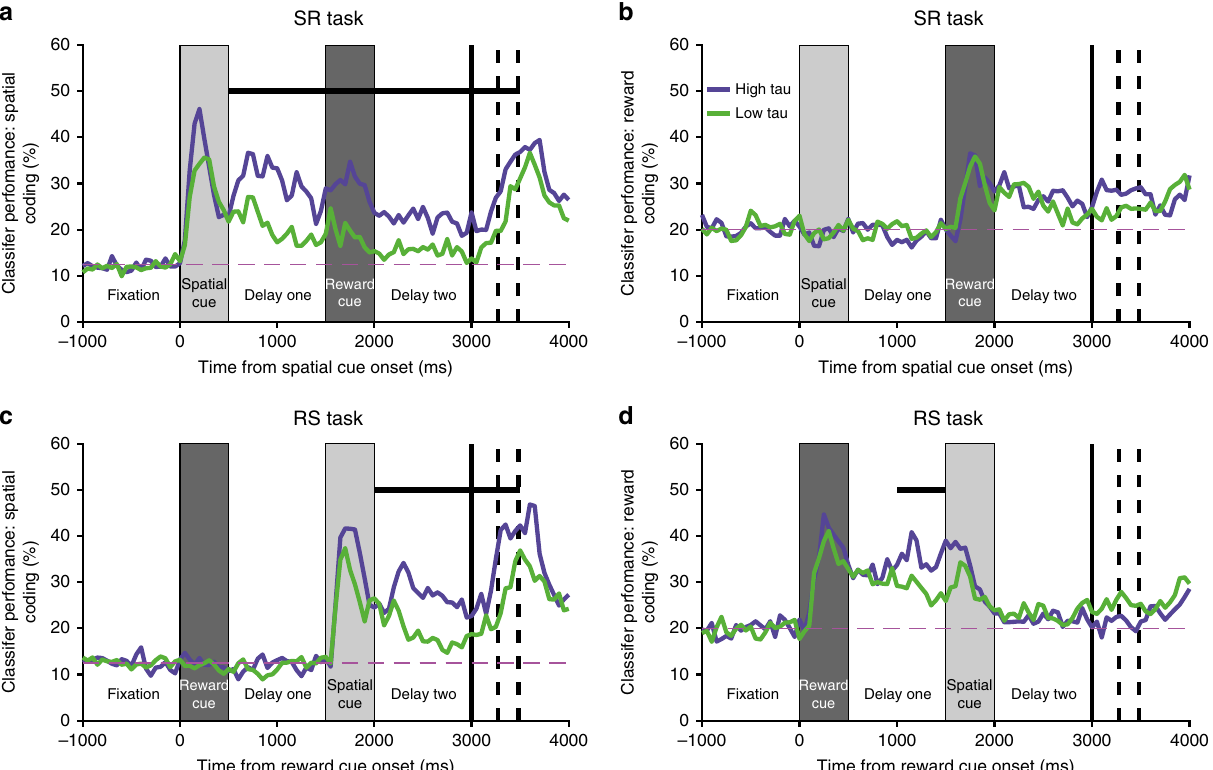
Fig. 3 Ventrolateral prefrontal neurons with higher resting time-constants maintain reward and spatial information across delays. The mean performance of classi fi ers (1000 permutations, Methods) trained to decode space ( a , c ) and reward size ( b , d ) is calculated for two subpopulations of ventrolateral prefrontal cortex (VLPFC) neurons subdivided by resting time-constant. For spatial coding on the SR-task ( a ), the subpopulation with higher time- constants has a stronger representation during the fi rst delay ( fi rst 500 ms p = 0.00313, second 500 ms p = 0.00041, Bonferroni-corrected bootstrap tests; Methods), whilst the reward cue is on screen ( p = 7 × 10 − 5 ), during delay-two ( fi rst 500 ms p = 0.00824, second 500 ms p = 0.01736), and during the early response period ( p = 0.0355). The high time-constant population also has stronger spatial coding in delay-two of the RS-task ( fi rst 500 ms p = 0.03237, second 500 ms p = 0.0003, c ) and in the early response period ( p = 0.00461). Ventrolateral PFC high time-constant neurons also code reward more strongly during delay-one of the RS-task (Second 500 ms p = 0.0330, d ). Horizontal black bars represent a signi fi cant difference between the high and low time-constant subpopulations (Bonferroni-corrected bootstrap test for 10 non-overlapping 500 ms epochs; Methods, p < 0.05). The dashed magenta line represents chance level classi fi er performance. The fi rst solid vertical line signi fi es when subjects were cued to respond. The fi rst and second dashed vertical lines represent the average timing of the subjects ’ saccade and the onset of reward,